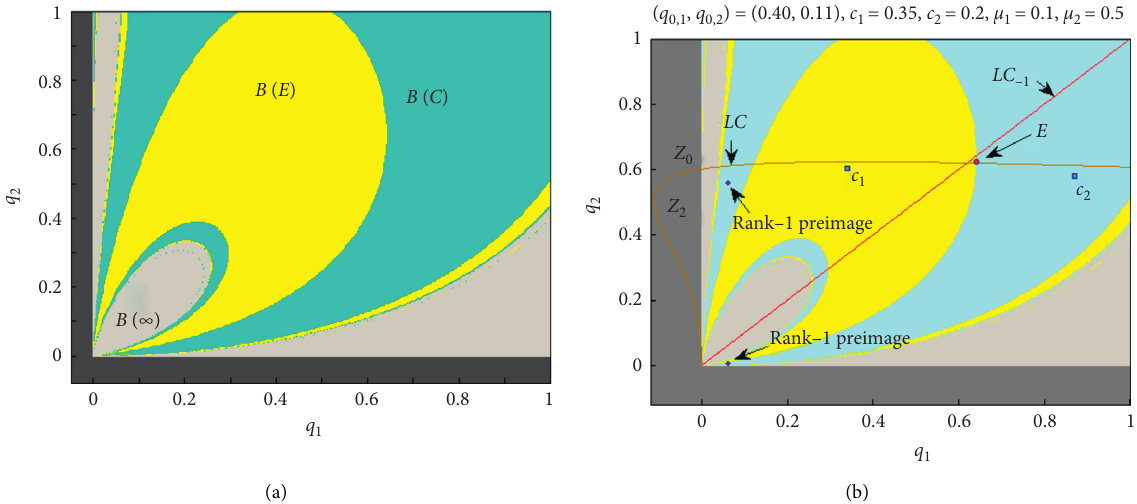
� 0 . 35 ,c � 0 . 2 , μ � 0 . 1 , μ � 0 . 5, and α � 5 . 8. The gray color refers 1 2 1 2